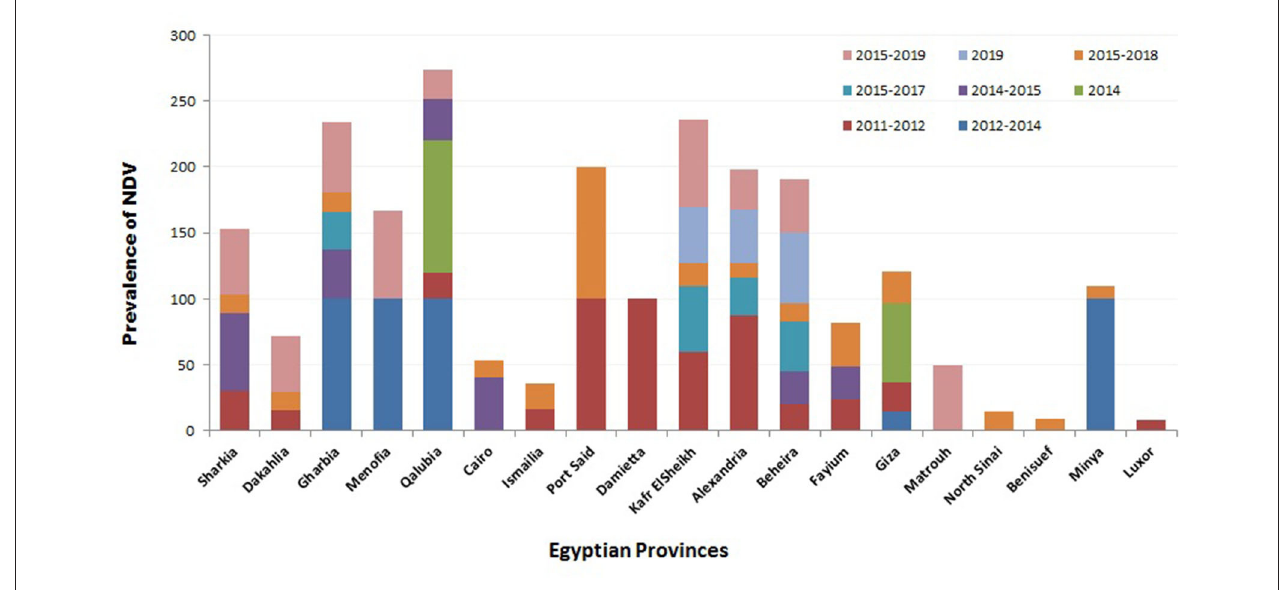
FIGURE 2 | Summary of Newcastle disease virus (NDV) prevalence studies in Egypt according to geographical (Egyptian province) and time (year of detection)